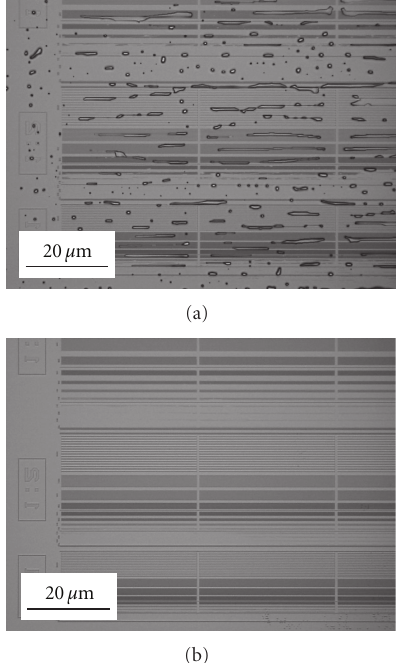
Figure 4: Bubble defects: (a) in the case of low-viscosity resin, bubble defects were observed, and (b) in case of high-viscosity resin, bubble defects were not